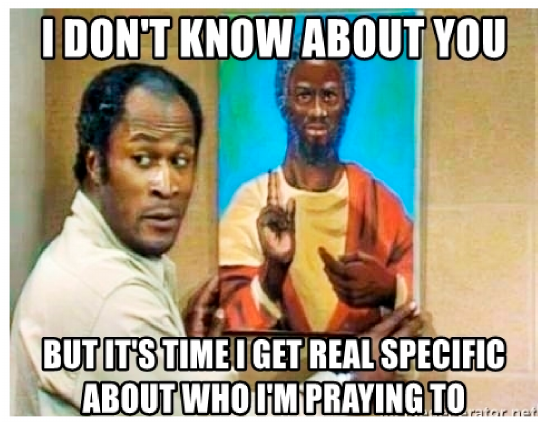
Figure 5. “I Don’t know about You, but it’s Time I Get Real Specific about Who I’m Praying to”meme.